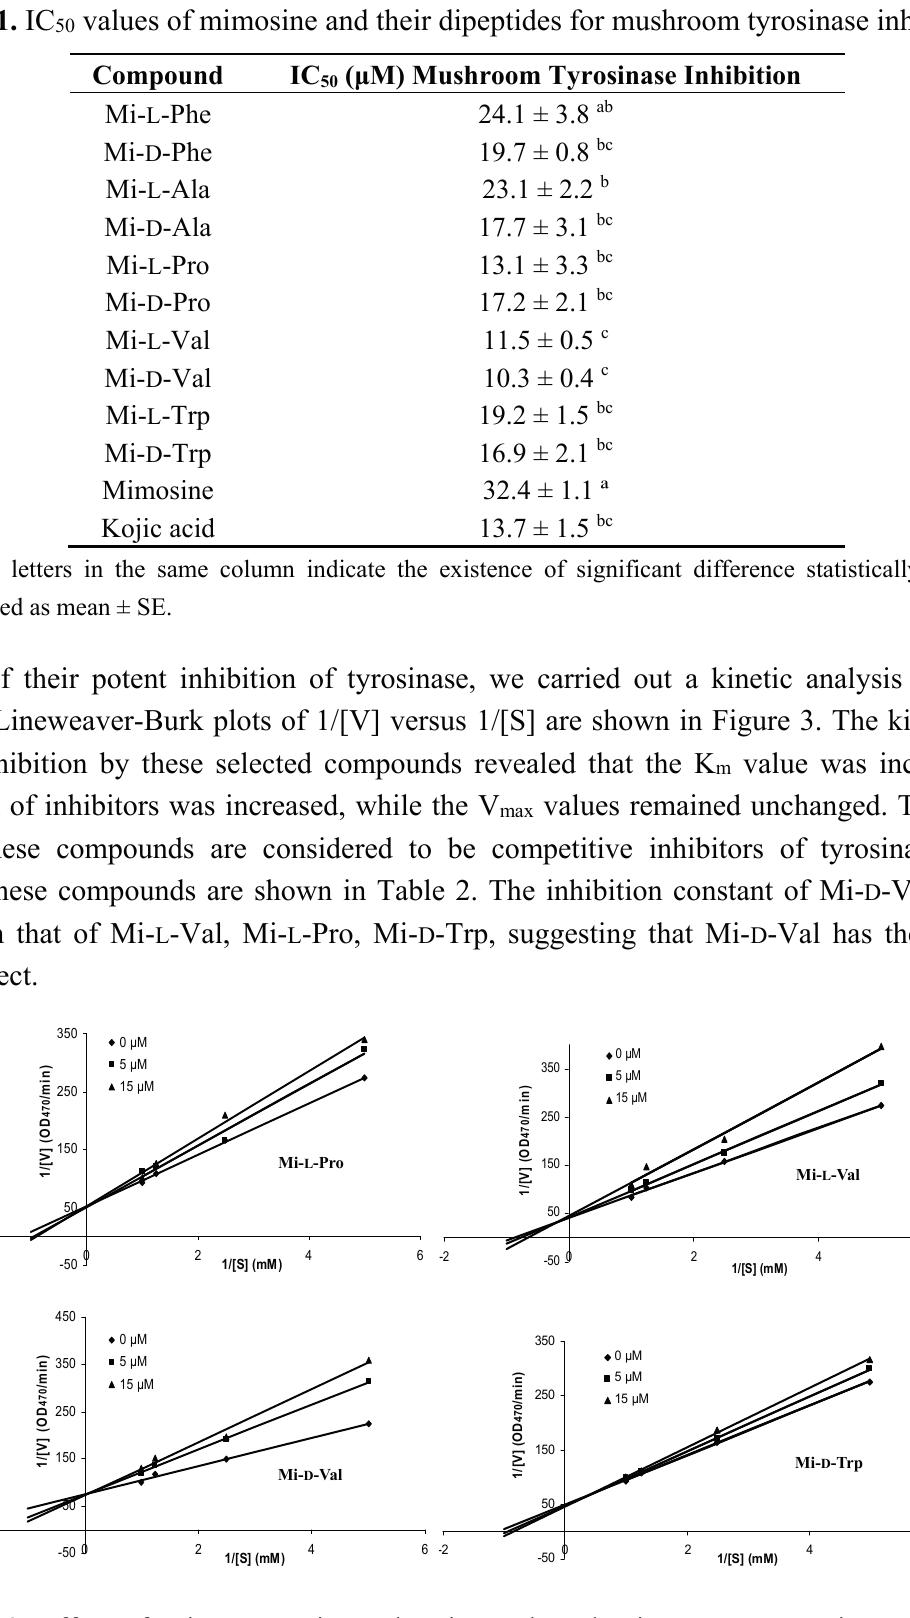
Figure 3. Effect of Mi- L -Pro, Mi- L -Val, Mi- D -Val, and Mi- D -Trp on tyrosinase activity. Tyrosinase activity was assayed as described in the text. Lineweaver-Burk plots were drawn in the presence of the compounds at various concentrations (0, 5, and 15 μ M) with different concentrations of the substrate L